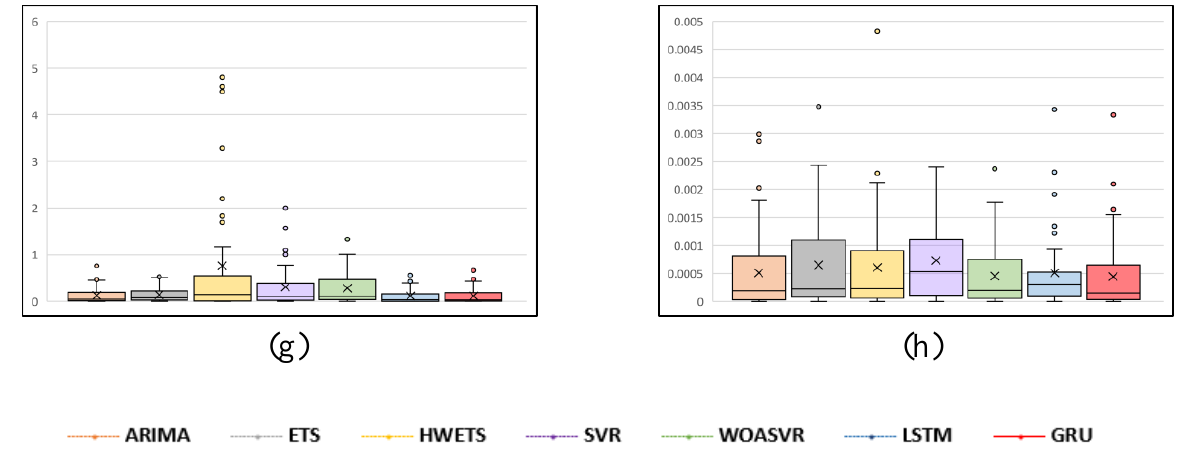
Figure 6. Scatter plots of power generation forecasts (48-month forecasts) for the period from 1 January 2017 to 31 December 2020, when different methods were used: forecasts of ( a ) coal power, ( b ) LNG power, ( c ) oil power, ( d ) conventional hydropower, ( e ) solar photovoltaic power, ( f ) wind power, ( g ) nuclear power, and ( h ) pumped hydropower.